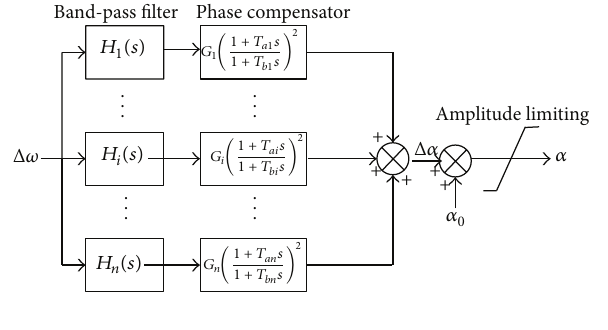
Figure 1: Structure diagram of SSDC.